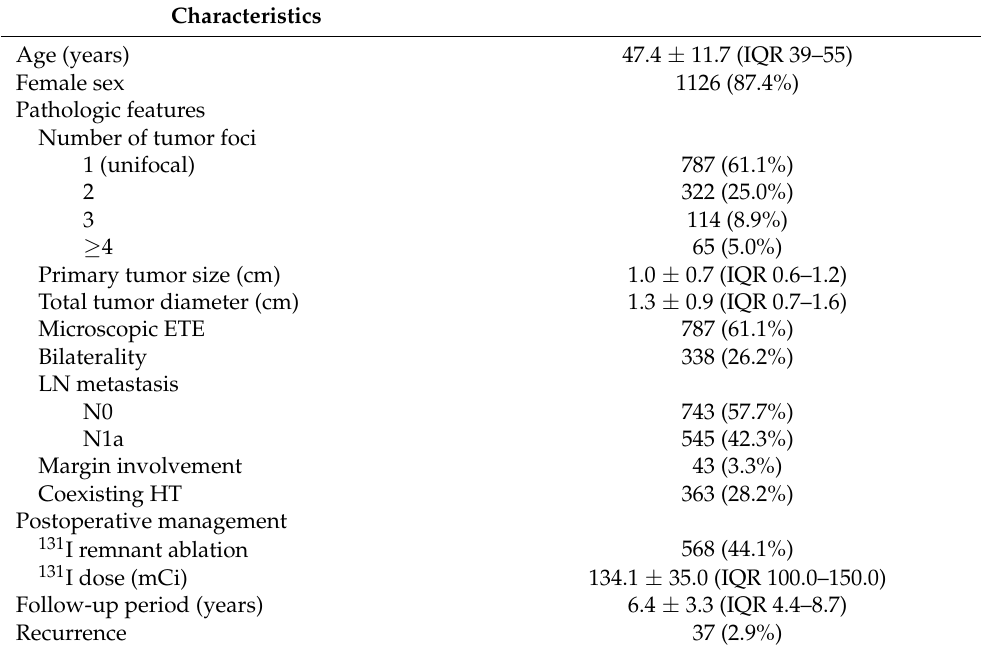
Table 1. Comparison of clinicopathological characteristics between patients with multifocal PTCs and those with unifocal tumor.